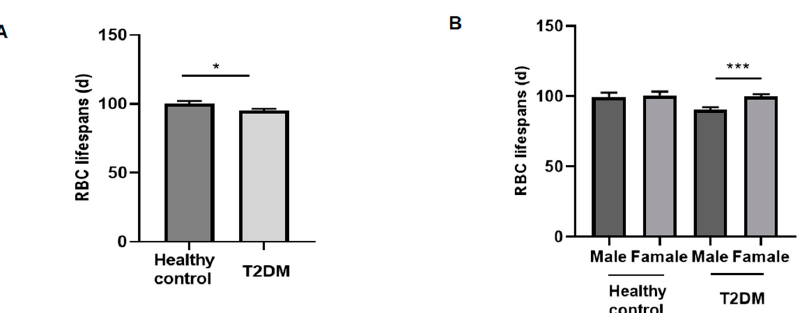
Figure 2. Comparison of RBC lifespans between healthy control and patients with type 2 diabetes mellitus (T2DM): ( A ). Comparison of red blood cell (RBC) lifespans in the two groups. ( B ). Comparison of red blood cell (RBC) lifespans in male and female of two groups, respectively.* p < 0.1, *** p < 0.001.